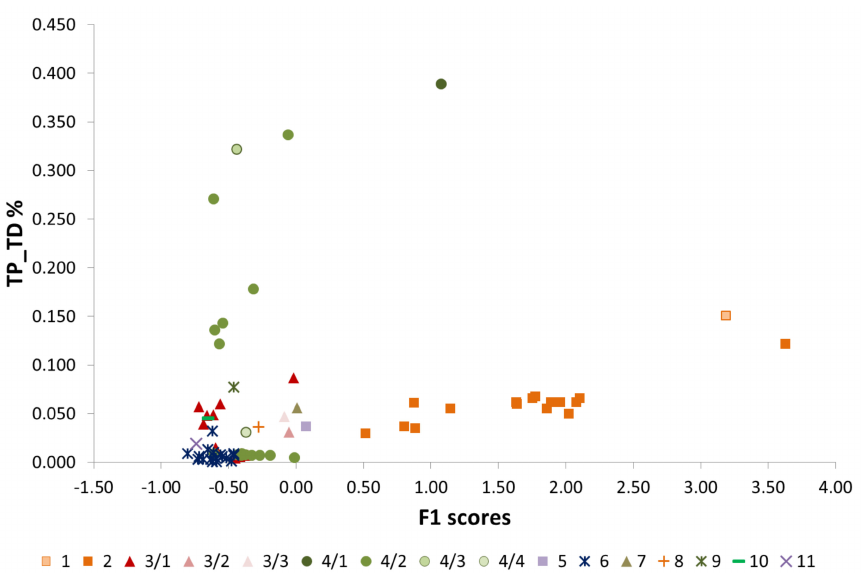
Figure 7. TP TD versus F1 scores for all the sediment samples of this study, distinguished by